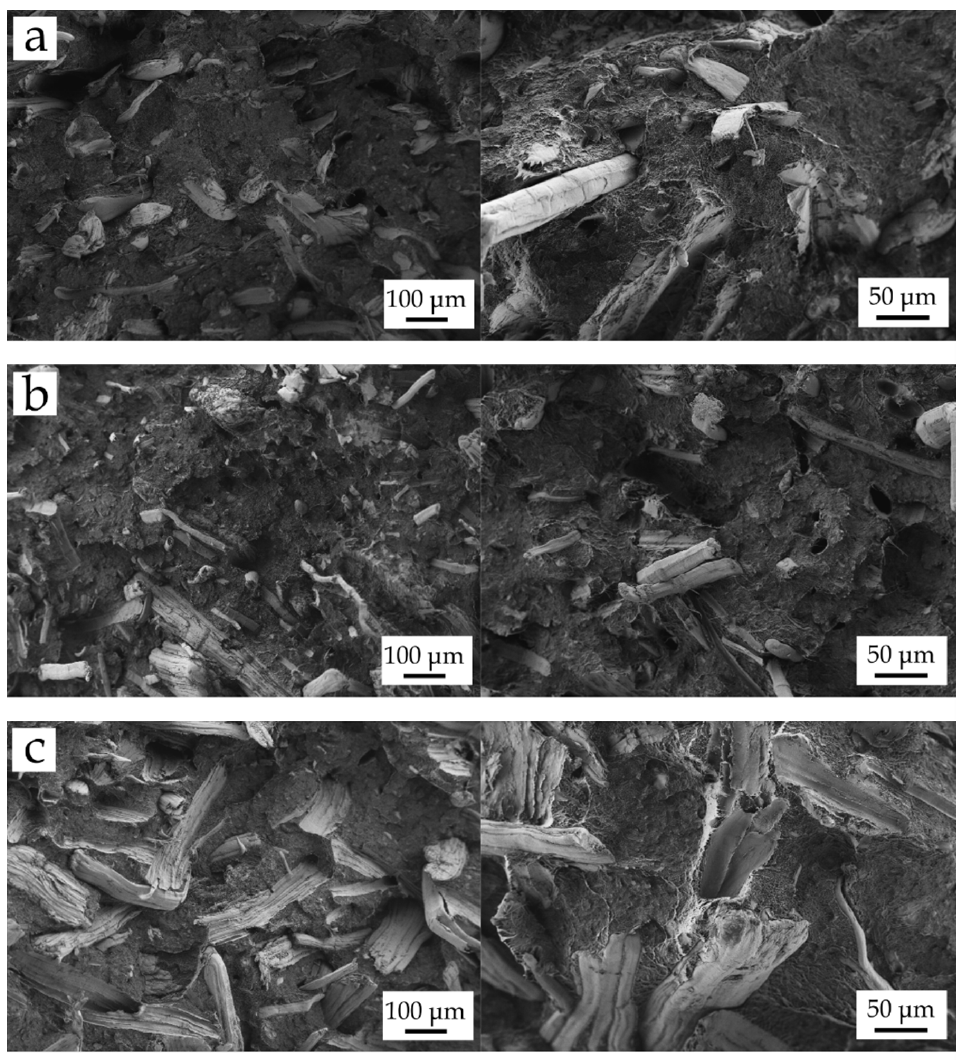
Figure 4. Field emission scanning electron microscopy (FESEM) images at 100 × (left) and 250 × (right) of the fracture surfaces of the different BioHDPE composites: ( a ) BioHDPE/Hemp/PE- g -MA; ( b ) BioHDPE/Flax/PE- g -MA and ( c ) BioHDPE/Jute/PE- g -MA.